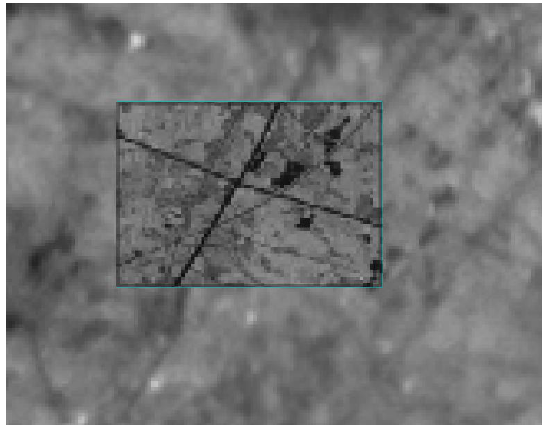
Figure 8. 50 m resultant images of July 24